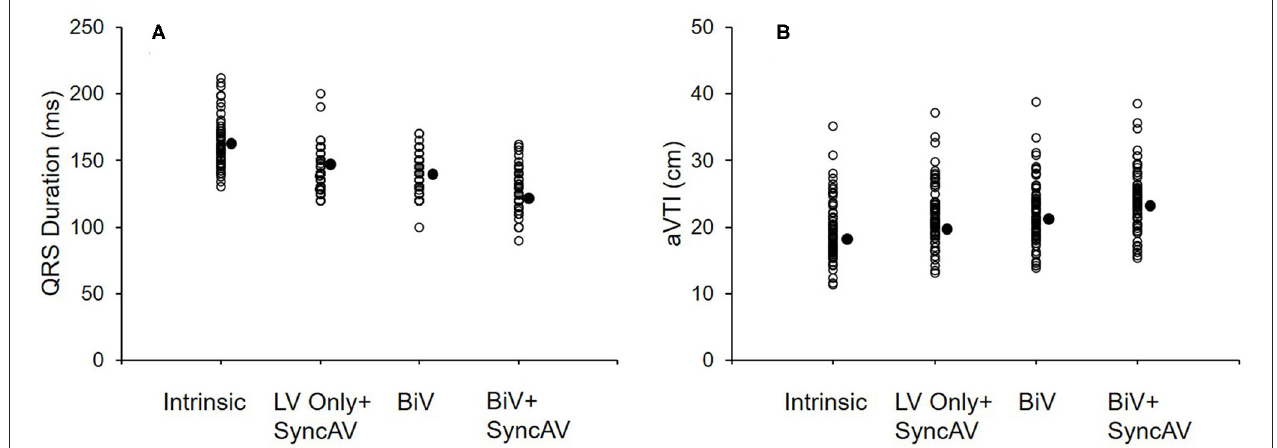
FIGURE 2 | QRS interval at baseline and three different pacing modes (LV only + SyncAV, BiV, or BiV + SyncAV) in the BiV + SyncAV group (A) ; aVTI score at baseline and three different pacing modes (LV only + SyncAV, BiV, or BiV + SyncAV) in the BiV + SyncAV group (B) .